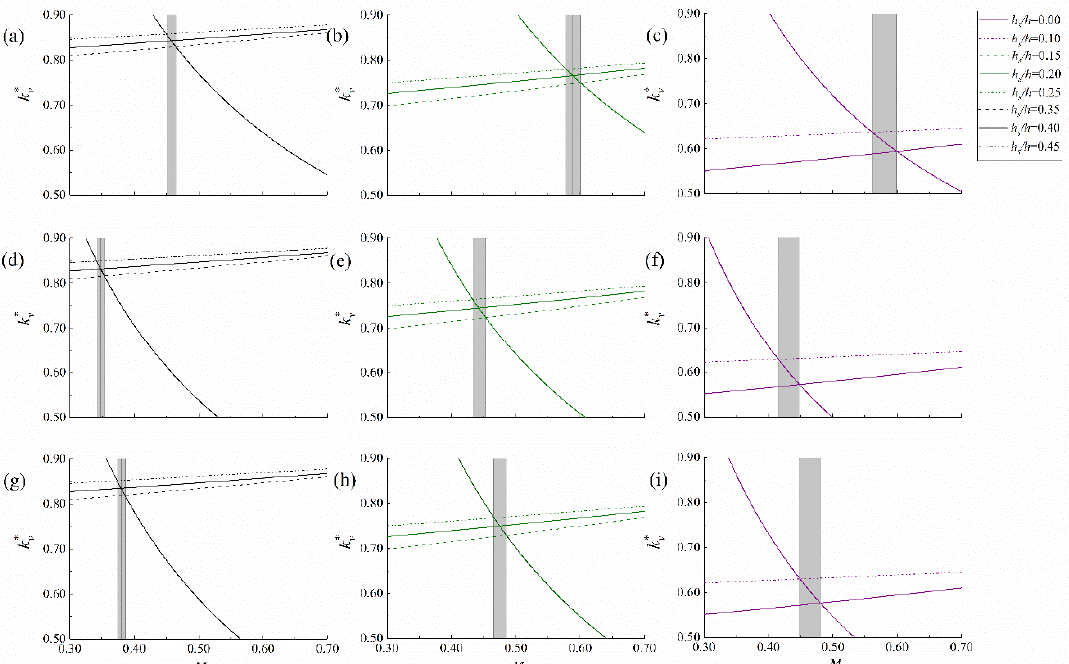
Figure 7. Changes in M 0 with variations in the stem fraction ( h s / h ). In this study, the observed h s / h of broadleaf forest ranged from 0.35 to 0.45 with the original value of 0.40 in the model; the observed h s / h of scrub ranged from 0.15 to 0.25 with the original value of 0.20, and the observed h s / h of steppe ranged from 0.00 to 0.10 with the original value of 0.00. The intersection of the auxiliary vertical line and abscissa is M 0 . Vegetation types and soil texture types: ( a , d , g ) Broadleaf forest; ( b , e , h ) scrub; ( c , f , i ) steppe; ( a – c ) sandy loam; ( d – f ) loam; ( g – i ) loamy clay, clay loam, or sandy clay loam.